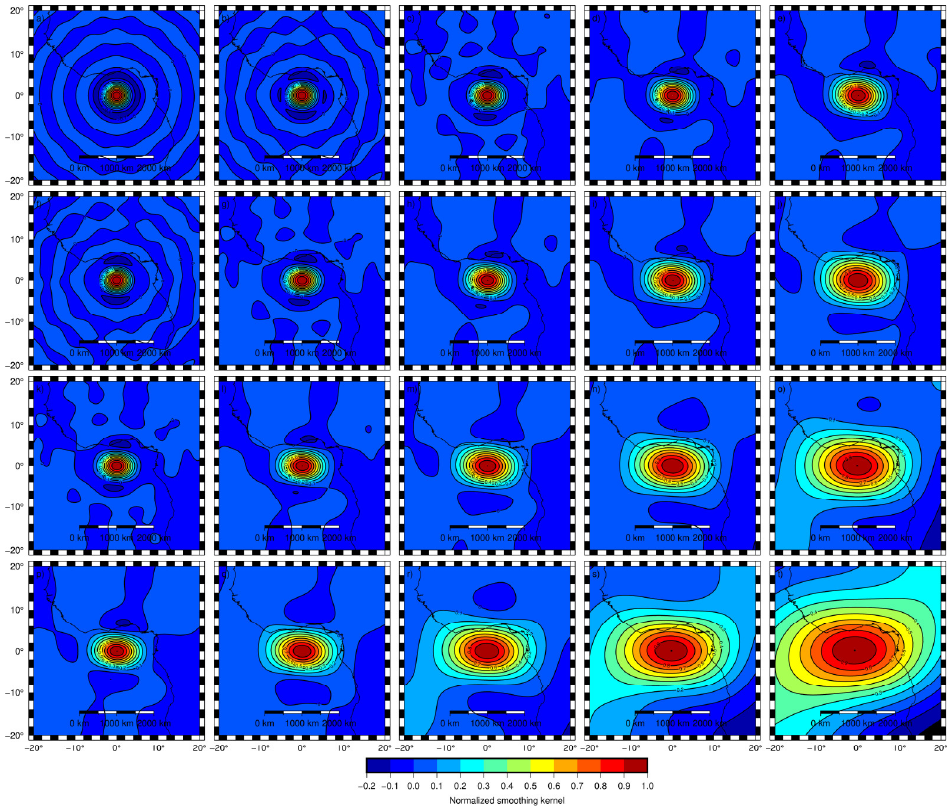
Figure 14. The normalized smoothing kernel (located at 0°E, 0°N) of different regularization coeffi- cients and different power indices with ECM in September 2006. ( a – t ) The regularization coefficients from top to bottom are 1 × 10 15 , 1 × 10 16 , 1 × 10 17 and 1 × 10 18 , respectively. The power indices of SCMs from left to right are 4.0, 4.5, 5.0, 5.5, and 6.0, respectively. Table 5. Filtering strength metrics of the kernel with different regularization coefficients and differ- ent power indices of SCM: equivalent smoothing radius (ESR) and half-weight polygon area (HWPA). The unit of HWPA is thousands of square kilometers, whereas that of ESR is kilometers. Indicator reg.\pow. 1 × 10 15